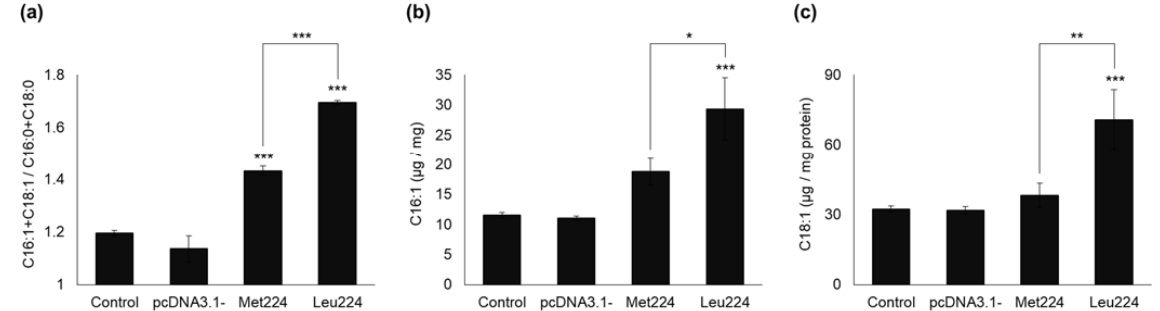
Figure 5. Changes in cellular fatty acid desaturation upon the over-expression of M224L variants. Transiently transfected HEK293T cells were harvested and the amount of major saturated (C18:0, C16:0) and mono-unsaturated (( a ) C18:1 cis Δ 9; ( b ) C16:1 cis Δ 9) fatty acids was measured by GC- FID after saponification and methylation as described in Section 4, ( c ) and the ratio of unsaturated: saturated fatty acids was calculated. Data were normalized to the total protein content of the sam- ples and are shown as mean values ± S.D.; n = 3. Statistical analysis was performed with the Tukey– Kramer Multiple Comparisons Test. * p < 0.05; ** p < 0.01; *** p < 0.001. As expected, transfection with a Met224 SCD1 expression vector led to a significant increase in the unsaturated: saturated FA ratio compared to control (1.43 ± 0.02 vs. 1.19 ±